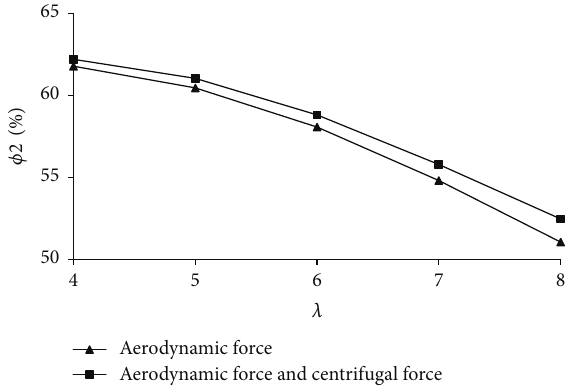
Figure 14: Variations of vibration frequencies of roundabout swing with working conditions defined by given tip speed and varying wind velocity.